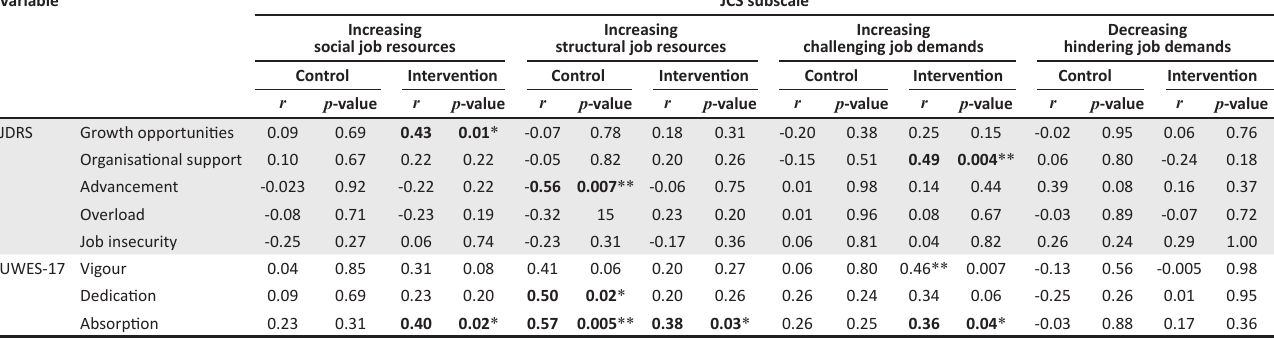
TABLE 5: Correlation matrix: Job Crafting Scale subscales, Job Demands-Resources Scale subscales and Utrecht Work Engagement Scale-17 subscales.